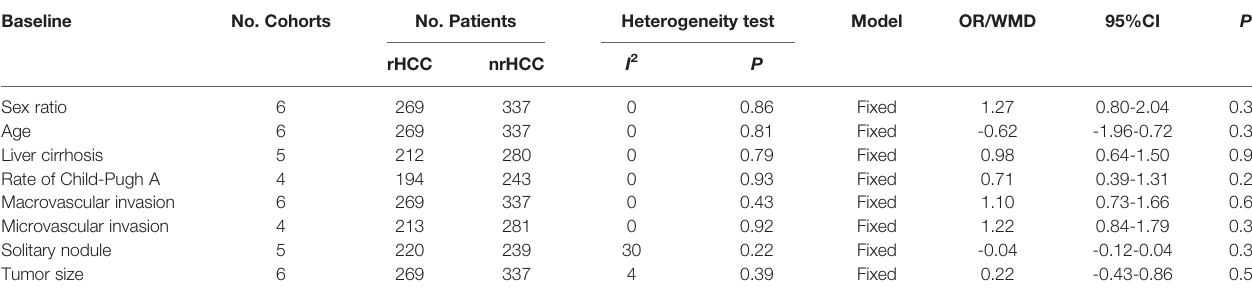
TABLE 2 | Meta-analysis results of all available studies in population characteristics of the included studies. Baseline